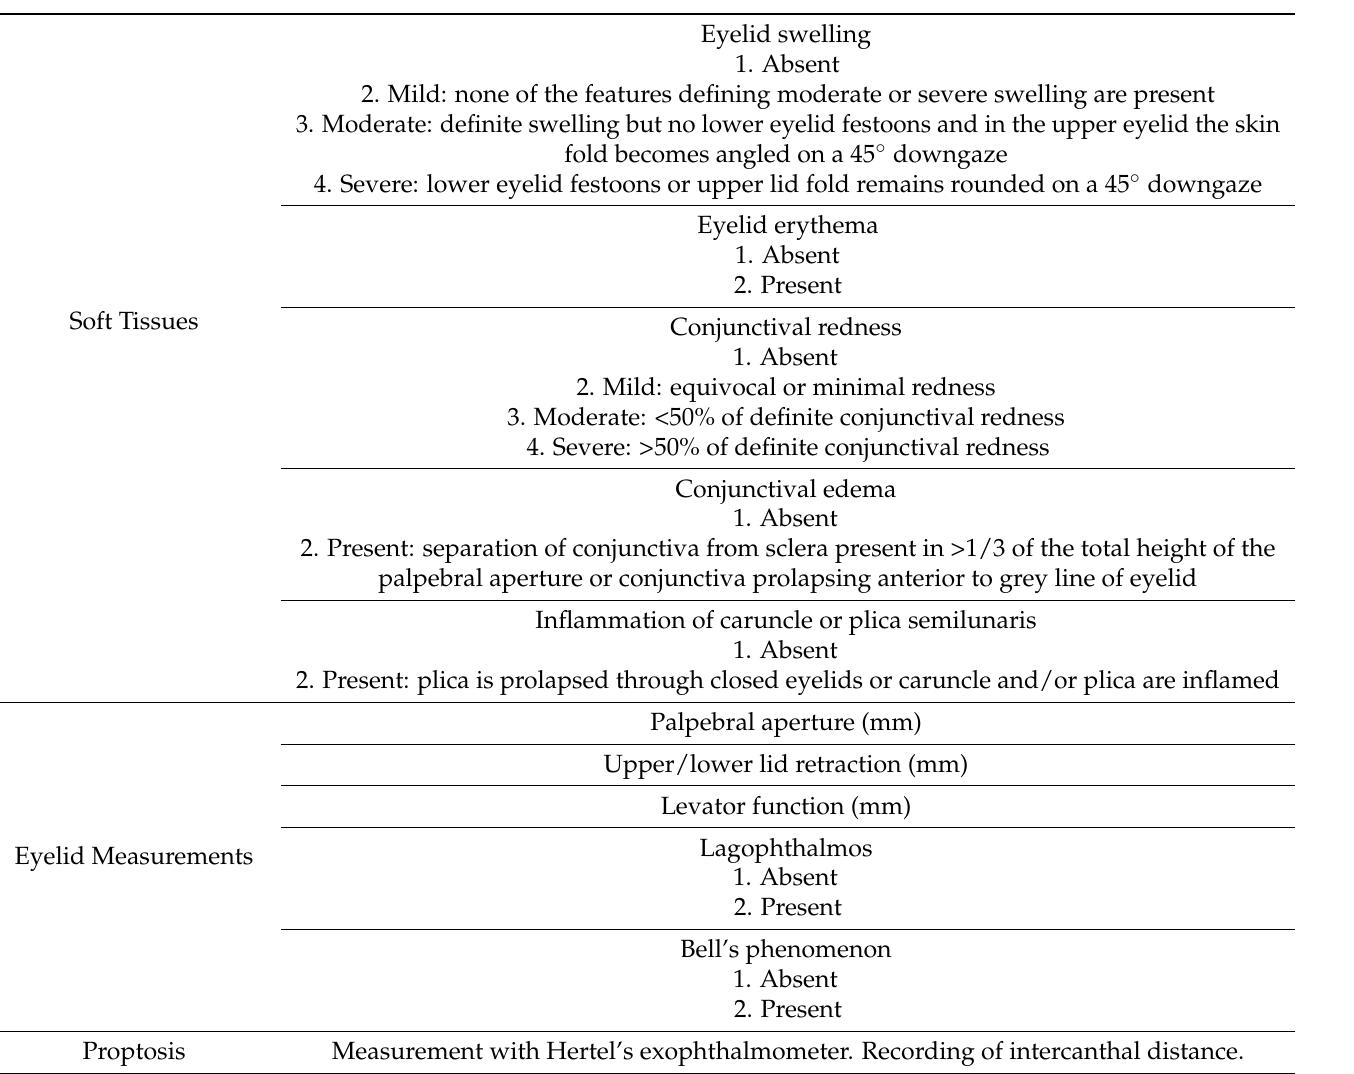
Table 5. EUGOGO protocol to assess the severity of Graves’ ophthalmopathy. Some of the signs may be assessed by comparison with the image atlas provided by the EUGOGO